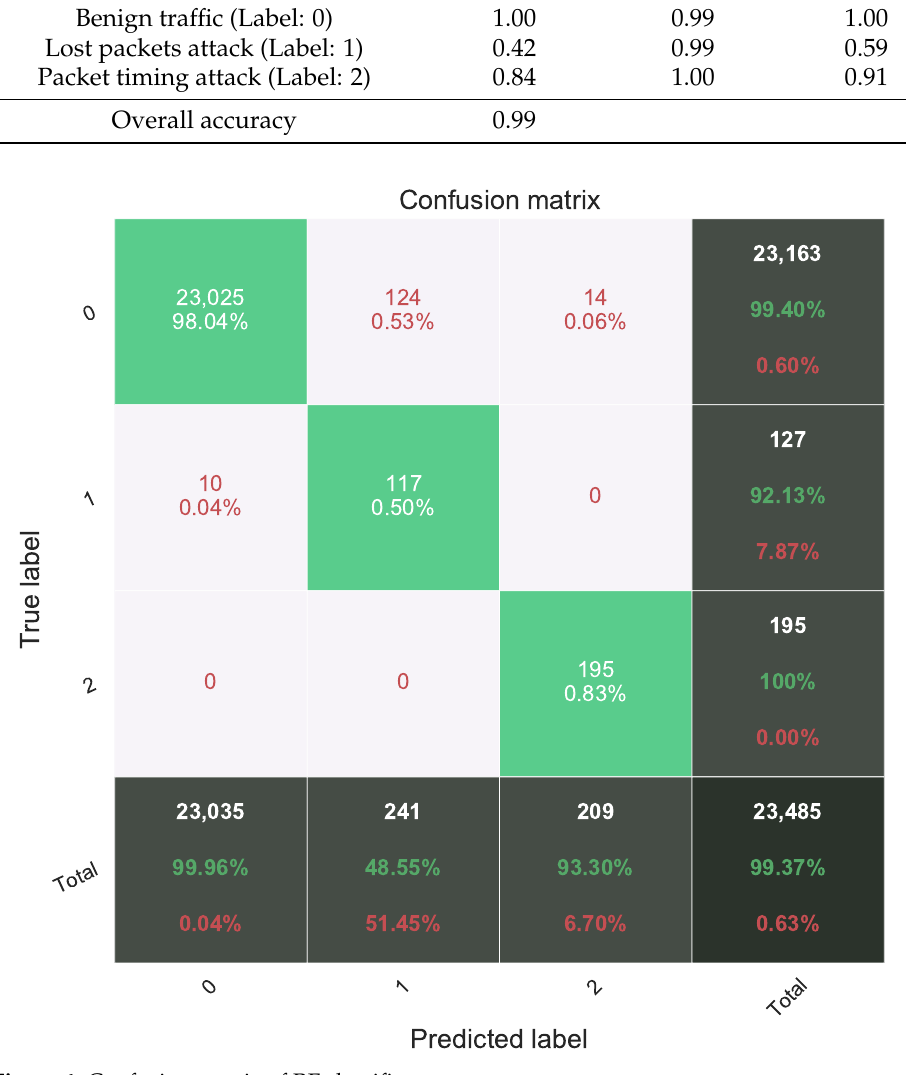
Figure 4. Confusion matrix of RF